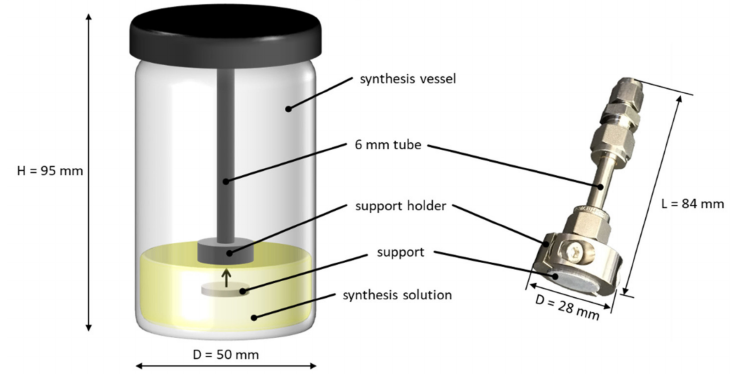
Figure 2. Schematic representation of the synthesis vessel with the support holder used for secondary growth ( left ) and image of the custom-made support holder ( right